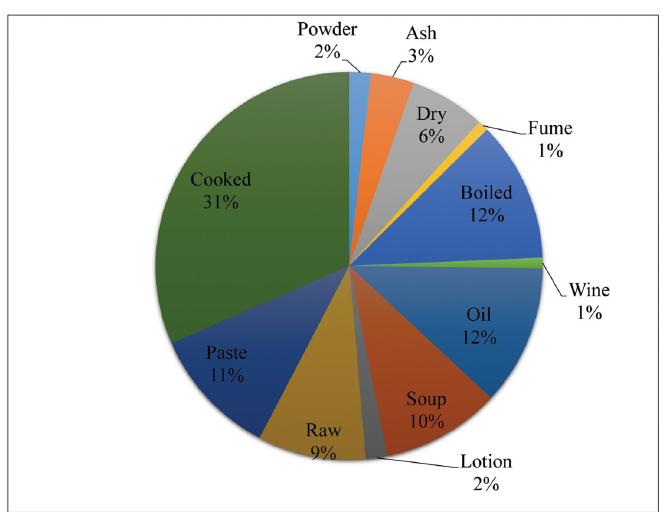
Fig 7. Mode of preparation of medicine from body parts of